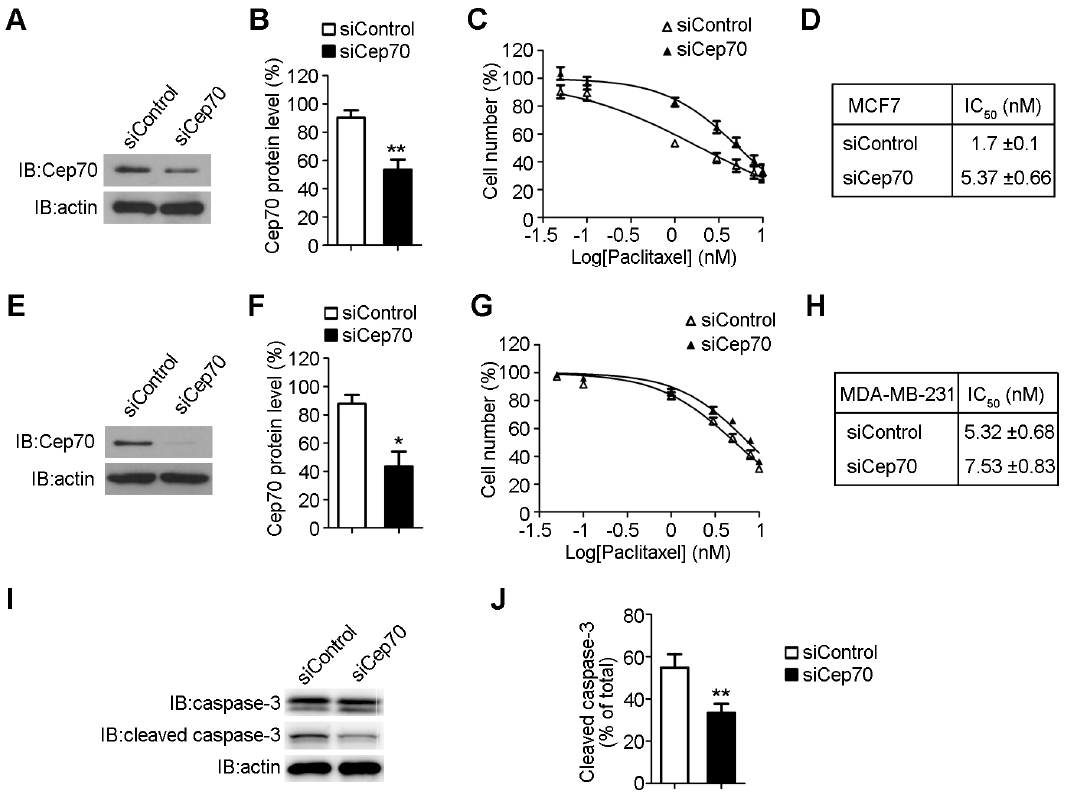
Figure 3. Knockdown of Cep70 expression reduces the sensitivity to paclitaxel of breast cancer cells. ( A ) MCF7 cells were transfected with control or Cep70 siRNA, and then collected for immunoblot analysis; ( B ) Experiments were performed as in ( A ), and the protein level of Cep70 was analyzed; ( C ) MCF7 cells transfected with control or Cep70 siRNA were treated with paclitaxel for 48 h. Cell